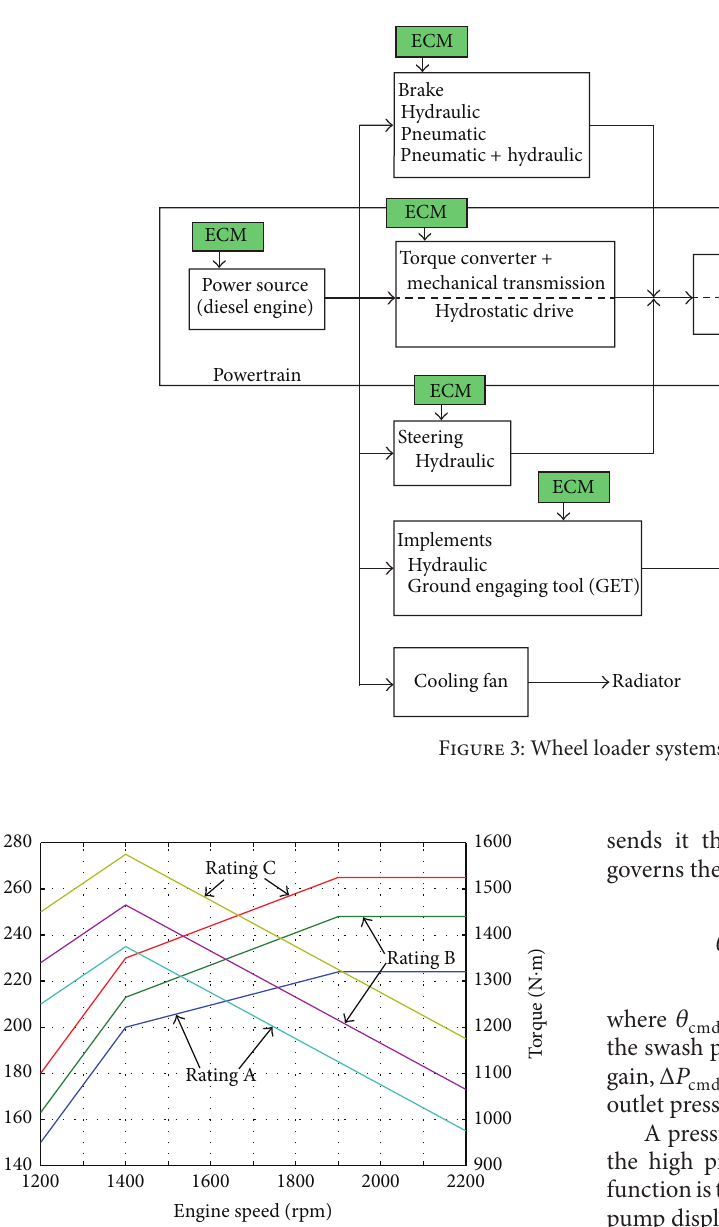
Figure 4: Rated engine lug curve and power